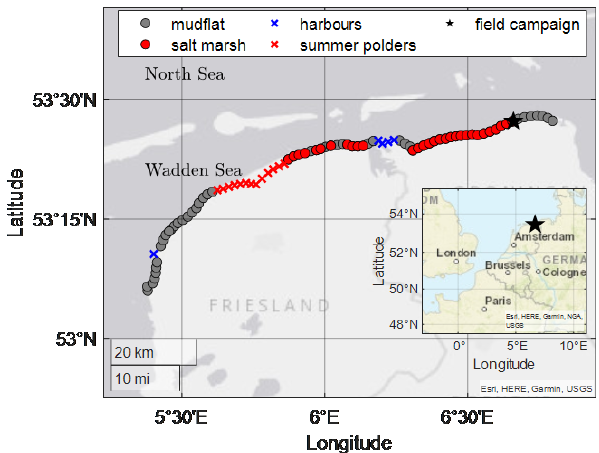
Figure 1. Location of the Dutch Wadden Sea, including its loca- tion in Europe (inset). Circles indicate the dikes considered, while “x” symbols were excluded from the analysis. Star indicates the lo- cation of the field site at Uithuizerwad.